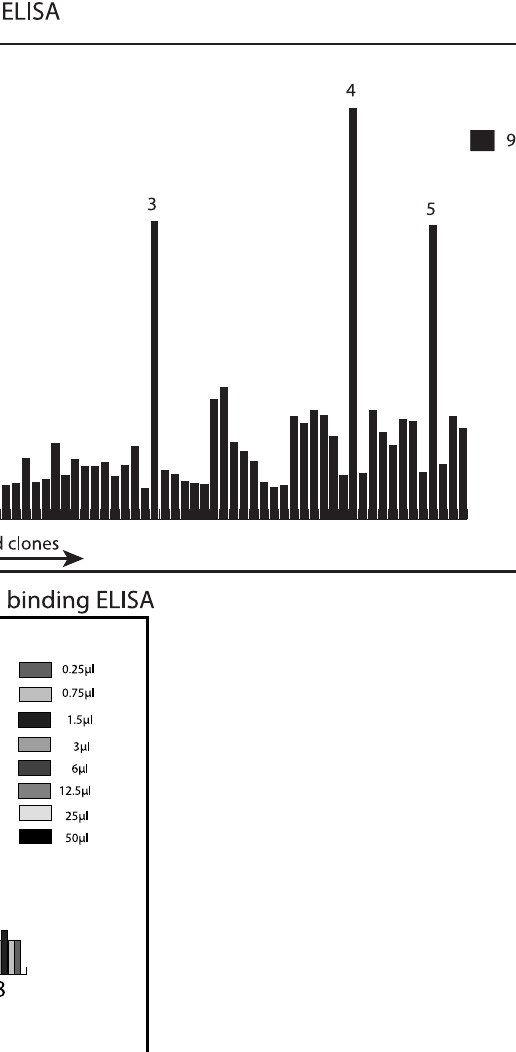
Fig 8. Isolation of bioactive recombinant scFv targeting CD20. (A). Soluble scFv fragment binding to its antigen. Biotinylated CD20 peptide (0.1 μ g/ml in 50 μ l) was coated onto streptavidin (1 μ g/ml in 50 μ l) coated solid phase and used as an antigen in the selection of scFv phage that bound to the CD20 epitope as indicated in the materials and methods. As the selection in rounds progressed, there was a reduction in the amount of antigen in the selection and an increased stringency of washing. (B). Colonies (96) from rounds 3 and 4 were grown in 200 μ l of LB media and induced overnight at 30°C to overproduce soluble scFv fragments. Following a freeze-thaw and sonication protocol to release scFv from the bacterial debris, the clarified lysate was assayed in the